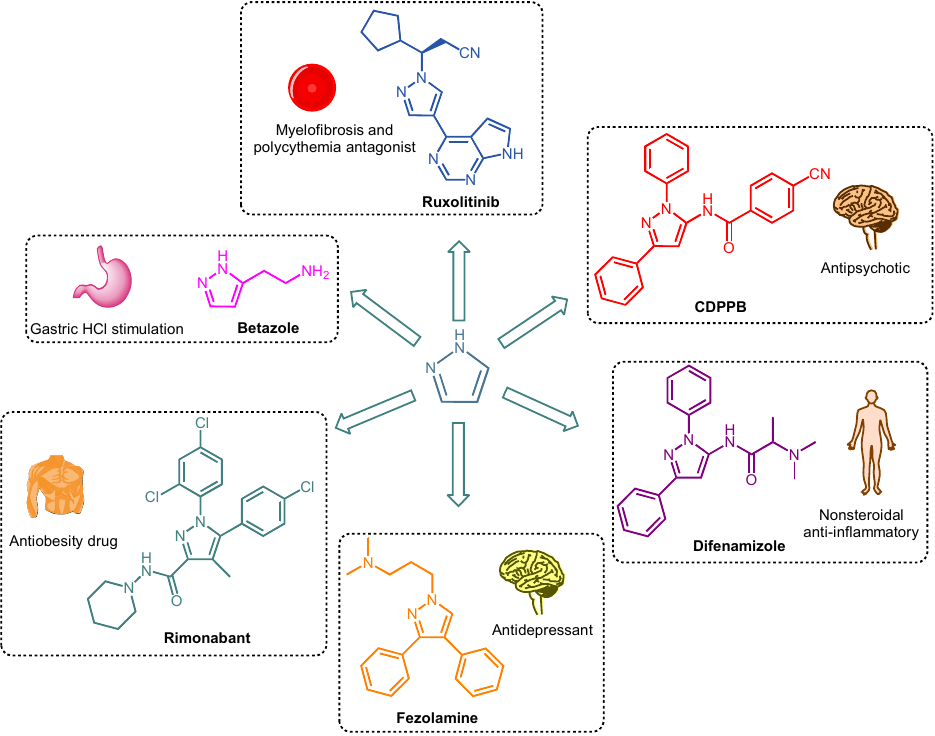
Figure 1. Clinical uses of drugs containing a pyrazole core .